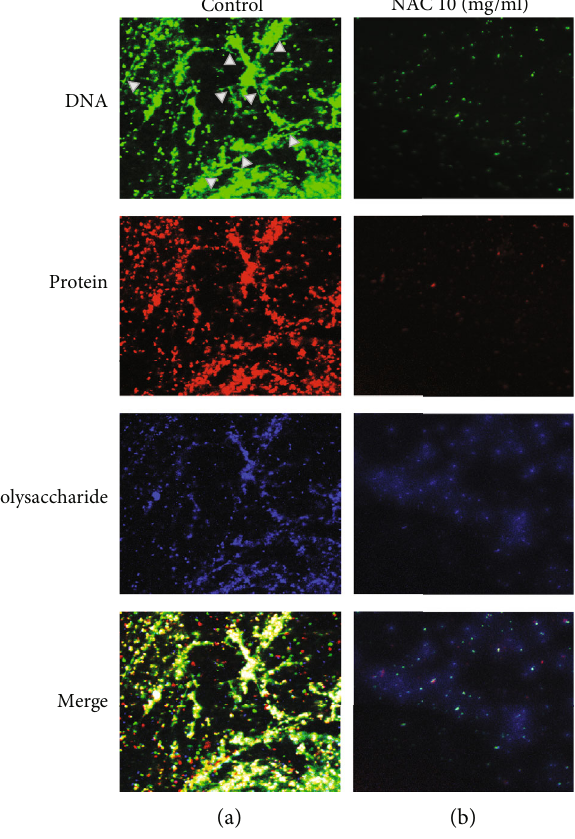
Figure 8: Fluorescence staining and confocal laser scanning microscopy analysis of the bio fi lm: DNA (green), proteins (red), and polysaccharides (blue) were visualized by staining with speci fi c stains as described in the Methods and Materials section. Pictures in (a) show that without the application of NAC, extracellular DNA molecules appear as strings in the matrix (arrowheads). The proteins are primarily found either in the bacteria which were planktonic or in aggregates. The carbohydrates are mostly in association with the planktonic bacteria and the bacterial aggregates. Pictures in (b) show that treatment with 10mg/ml NAC resulted in virtually no bacteria present and the EPS was found to be mostly gone. Biological duplicates for each treatment were used for the